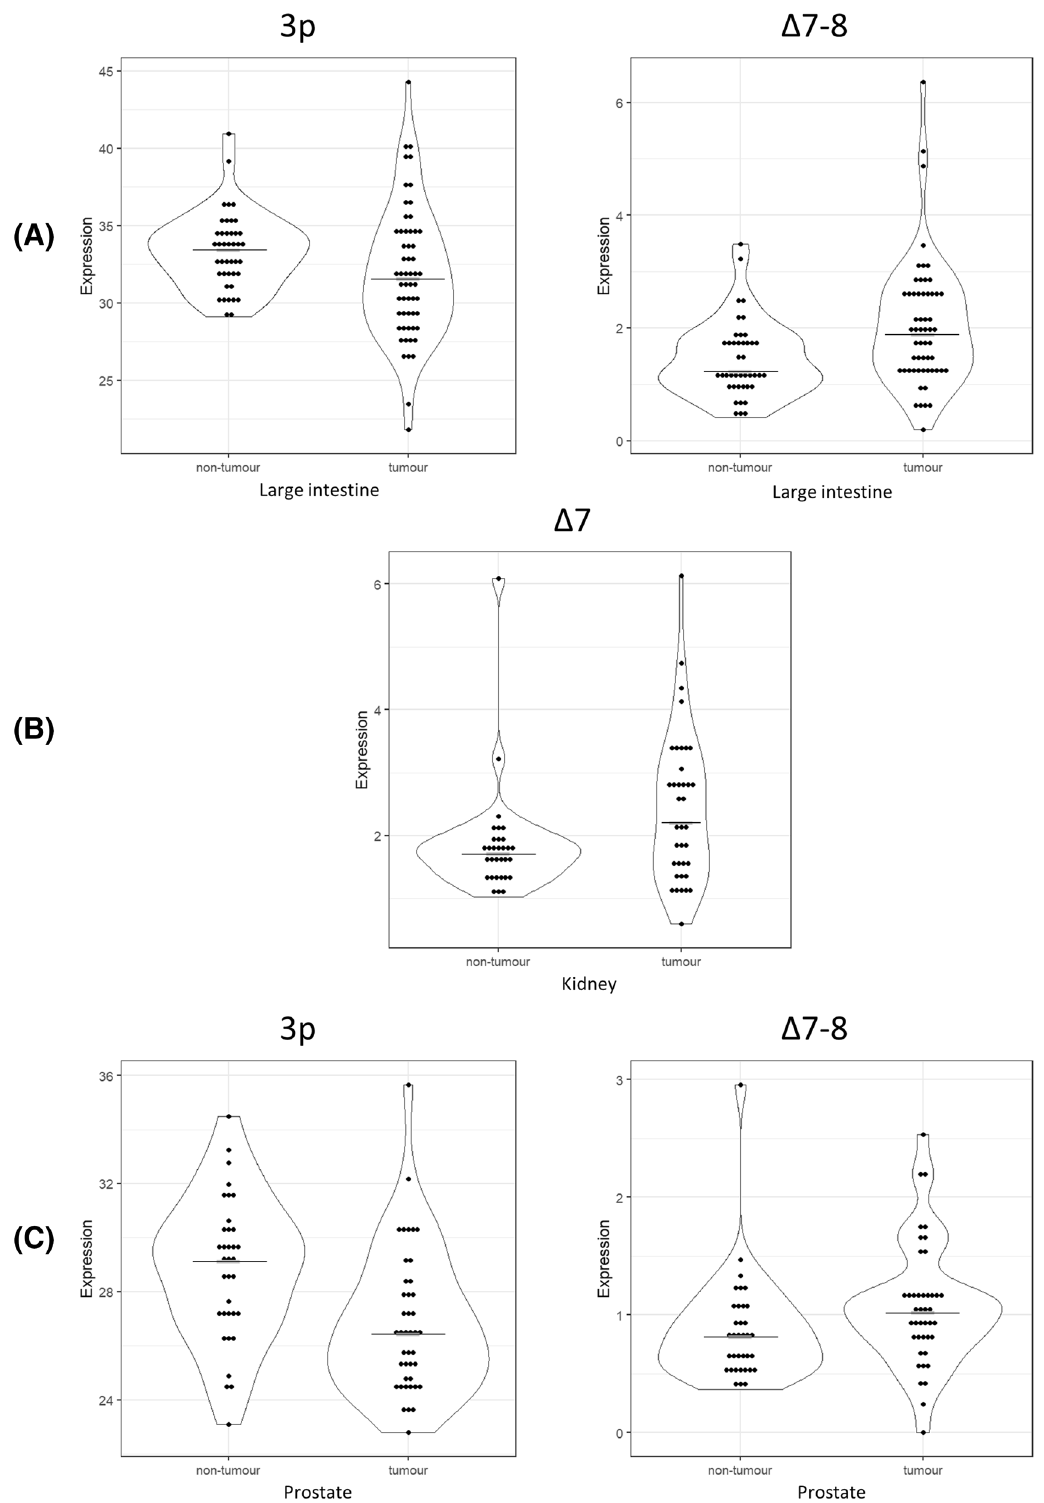
Figure 4. Significantly different expression levels of the HNF1B alternative splicing variants in T and NT tissue samples. ( A ) Large intestine (NT = 42 samples; T = 57 samples); ( B ) kidney (NT = 31 samples; T = 37 samples); ( C ) prostate (NT = 35 samples; T = 42 samples). Data is visualized as violin plots. Each dot represents one sample. Expression is relative to overall HNF1B mRNA expression (100). Black line represents median. Complete results are visualized in Fig.